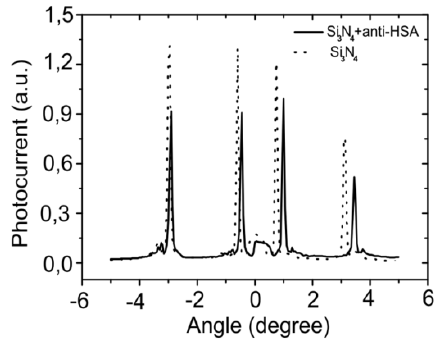
Figure 5. The laser beam is coupled inside the waveguide at different incoupling angles (depending on the covering layer). The spectrum is followed by the photodiodes placed at each end of the waveguide. The dash line shows the incoupling spectra of the bare chip covered with silicon nitride, and the continuous line after antibody